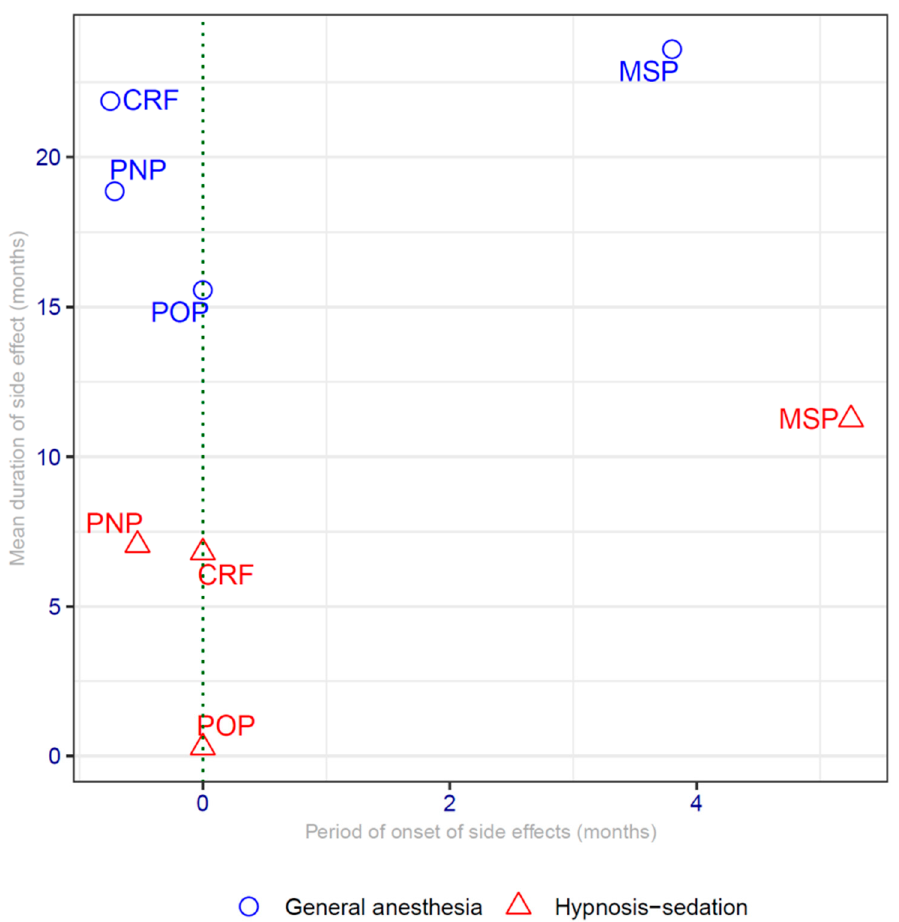
Figure 1. Timing and duration of side effects. CRF = cancer-related fatigue; MSP = musculo-skeletal pain; POP = post-operative pain; PNP= polyneuropathy; dotted vertical line: 0 = time of the surgery.